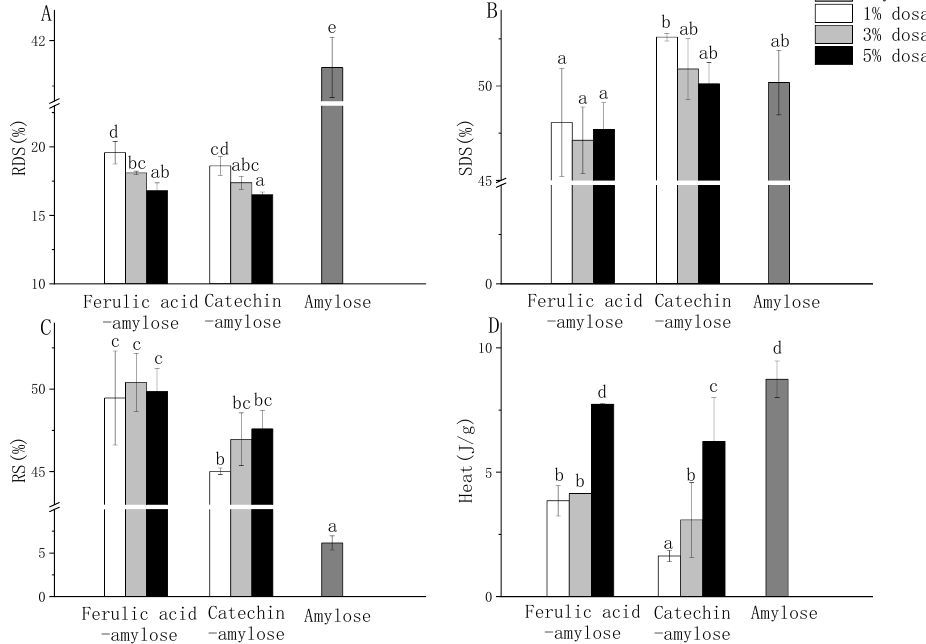
Figure 3. Effect of different standard and addition amounts on starch digestibility ( A – C ) and thermal properties ( D ) of polyphenol-amylose complex. Different letters represent significantly different ( p < 0.05).